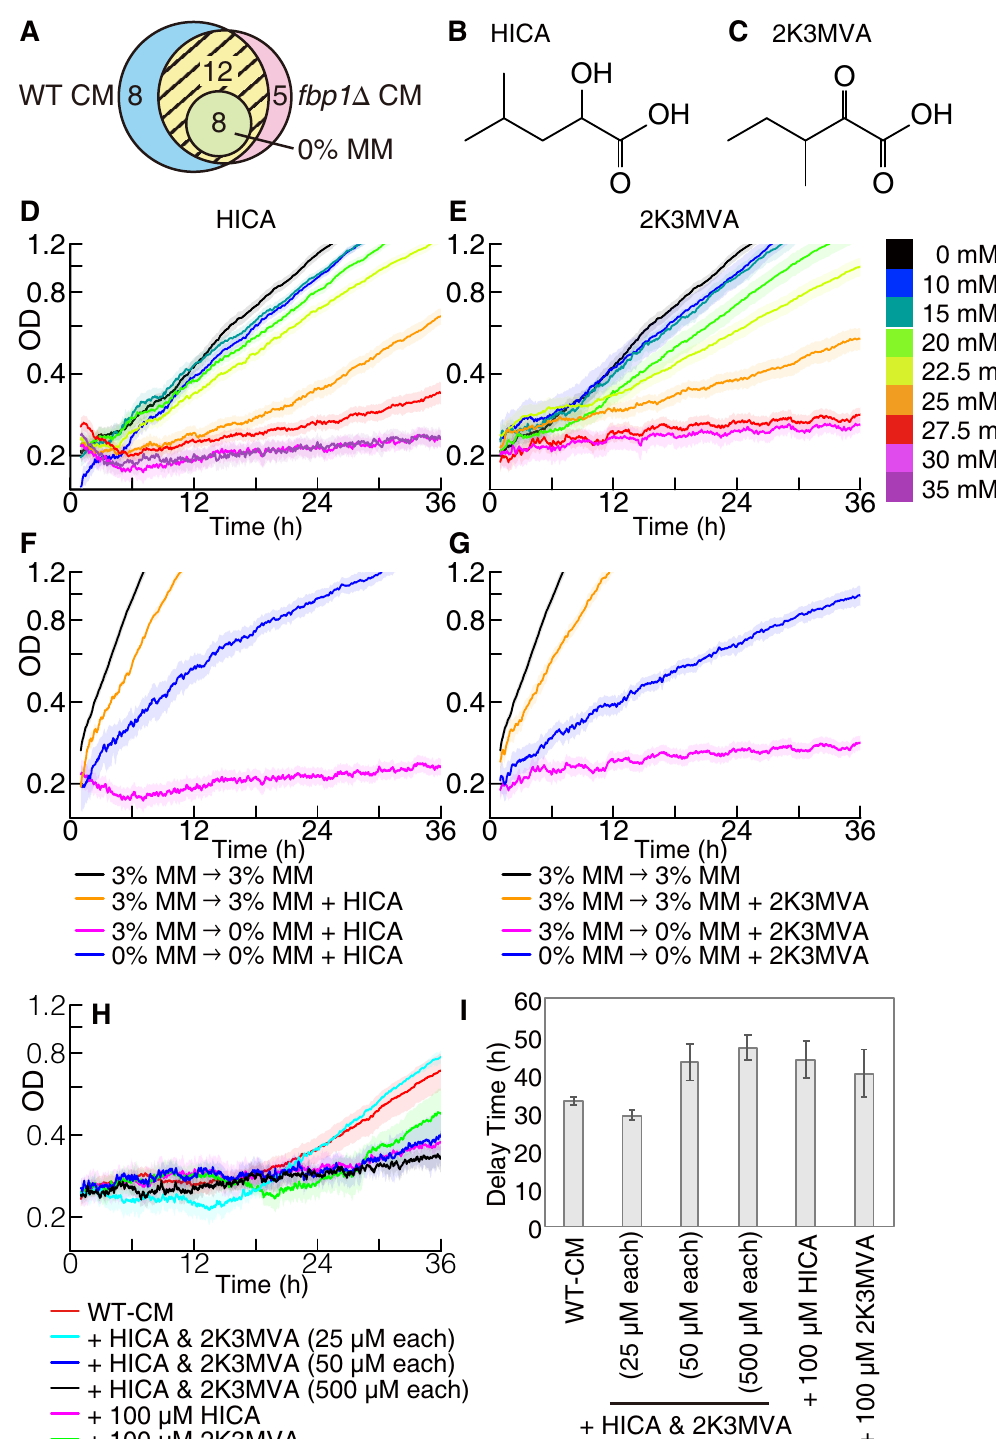
Fig 2. Identification of growth inhibitors. ( A ) Venn diagram of compounds detected using CE-MS. Compounds in 0% MM, WT CM, and fbp1 Δ CM were analysed. Twenty compounds were detected in both WT and fbp1 Δ CM, and 8 of those were also detected in 0% MM. Thus, 12 compounds (hatching area) were detected uniquely in both types of CM (see Table A in S1 Text for details of the detected molecules). ( B and C ) The structure of ( B ) HICA and ( C ) 2K3MVA. ( D and E ) Growth curves in 0%